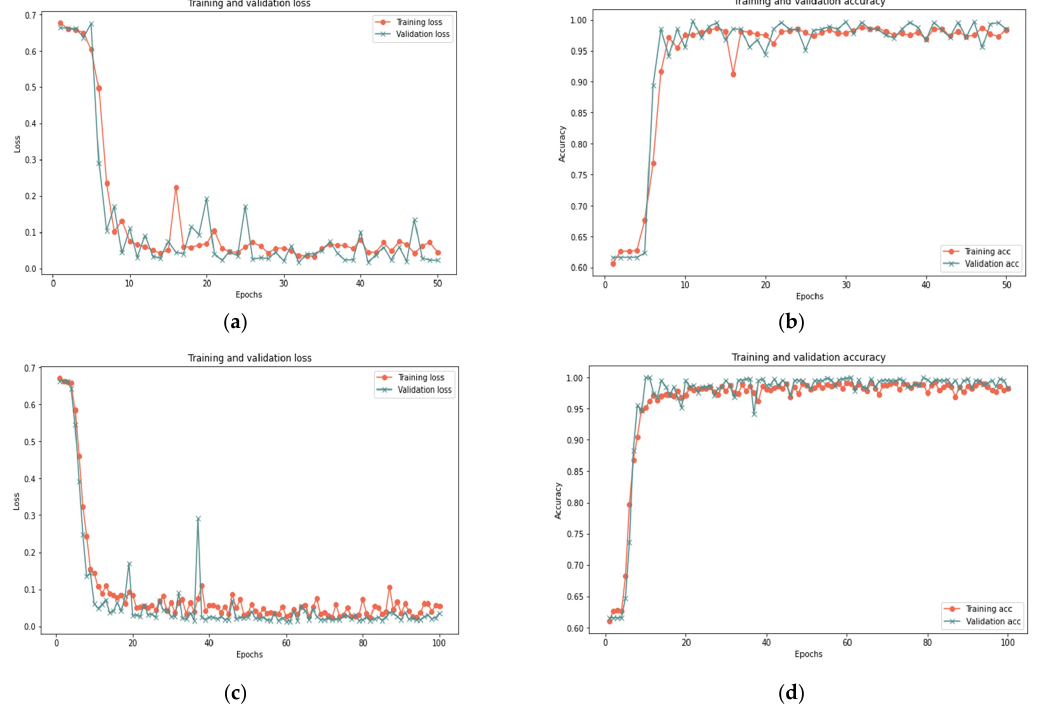
Figure 7. Results of the 25% sample size: ( a ) loss at 50 iterations; ( b ) accuracy at 50 iterations; ( c ) loss at 100 iterations; and ( d ) accuracy at 100 iterations.